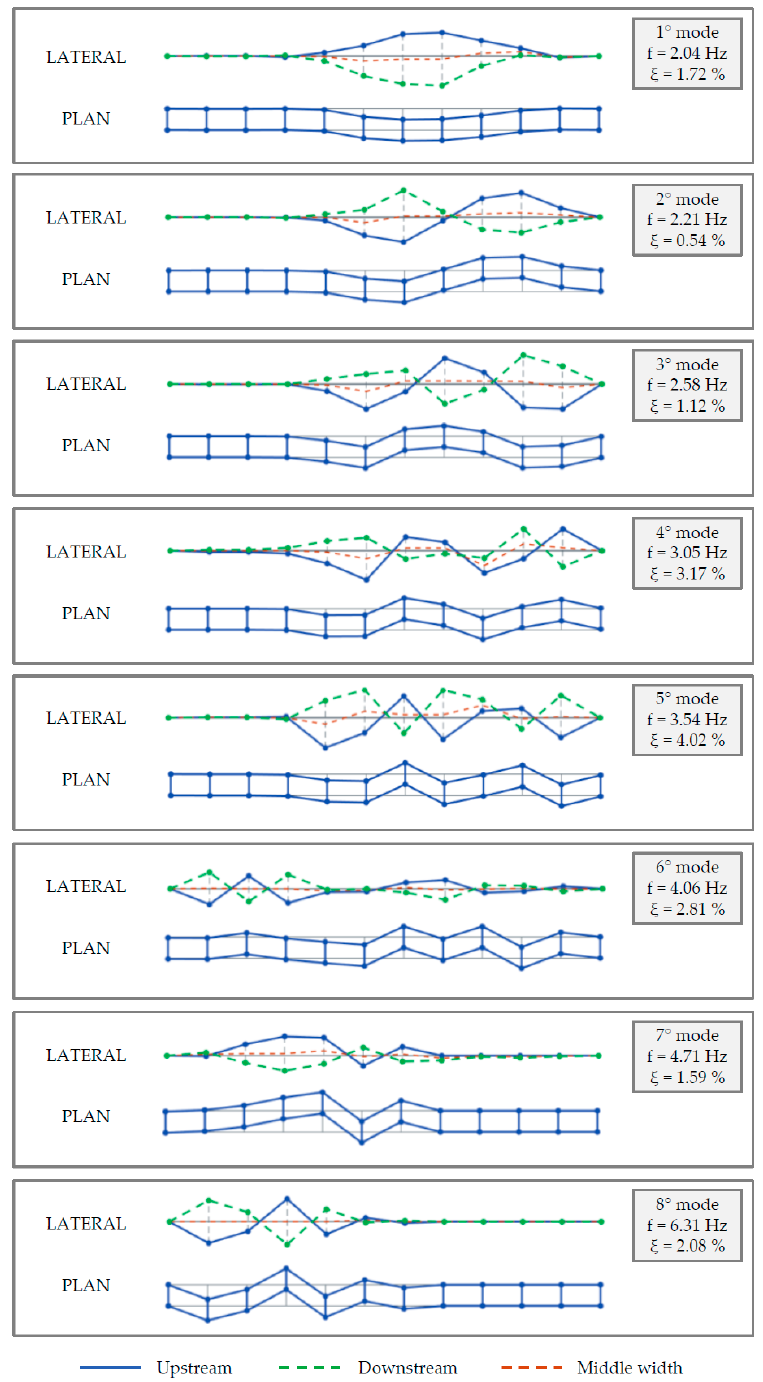
Figure 8. Experimental modal parameters obtained from OMA for the B1 bridge.